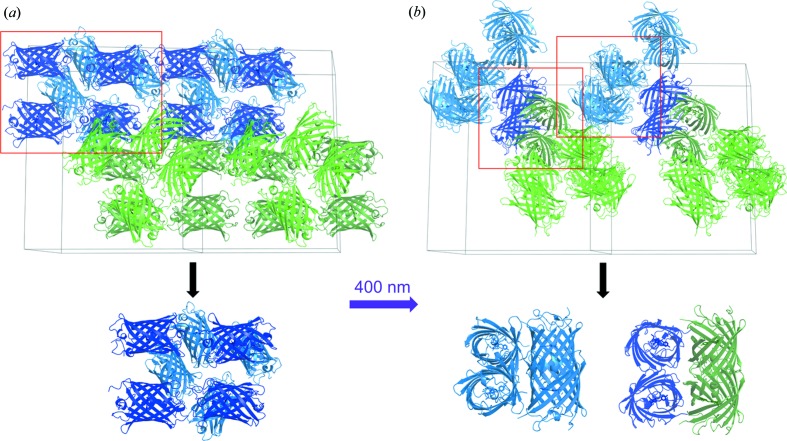
Crystal packing in Tetdron showing a super cell along the b axis. (a) Tetdron in the equilibrium state with a single asymmetric unit below. (b) Tetramers of the 400 nm irradiated Tetdron that form within the same asymmetric unit (blue) and within a neighbouring asymmetric unit (blue and green). Red boxes indicate the molecules that were used to generate the images shown immediately under the super cells.